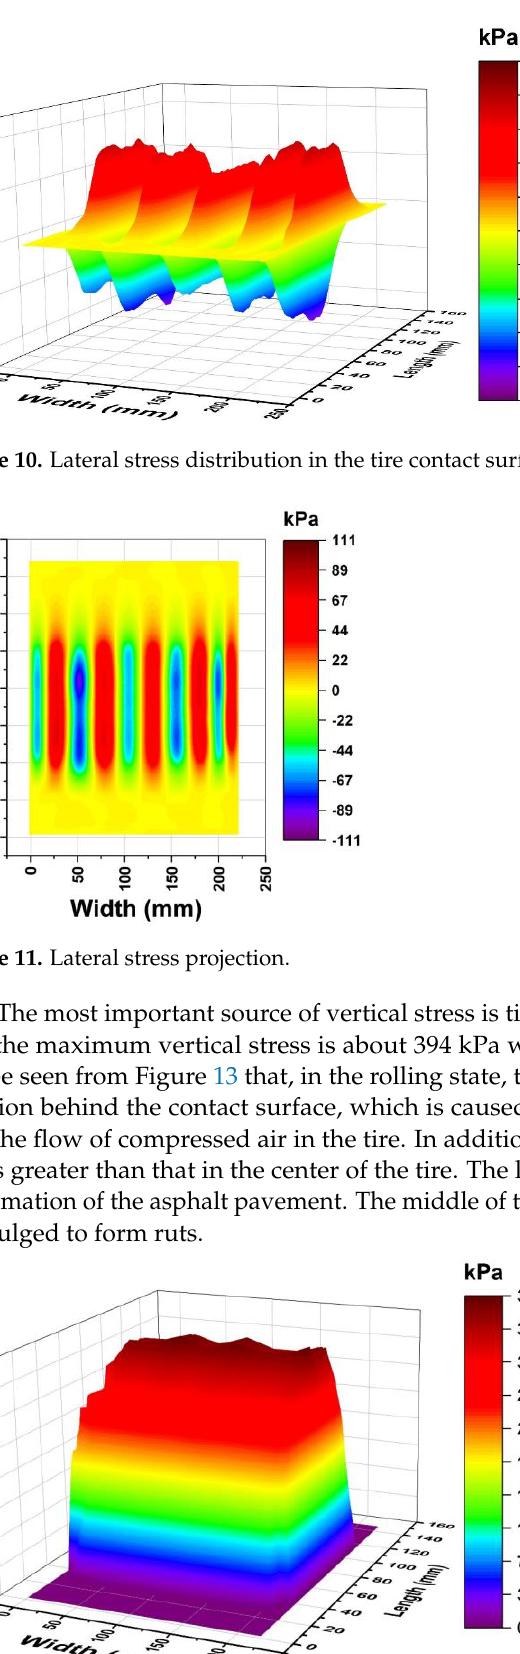
Figure 13. Vertical stress projection. 6. Conclusions In order to further study the contact stress distribution between the tire and the pave- ment, the sensor structure and strain gauge layout were improved, and the sensor cali- bration and correction were carried out. The sensor array considered the real pavement texture. A high-speed data acquisition system and testing platform were established to measure the tri-axial stress distribution of car tire under 2.4 bar inflation pressure. The following conclusions can be drawn: 1.